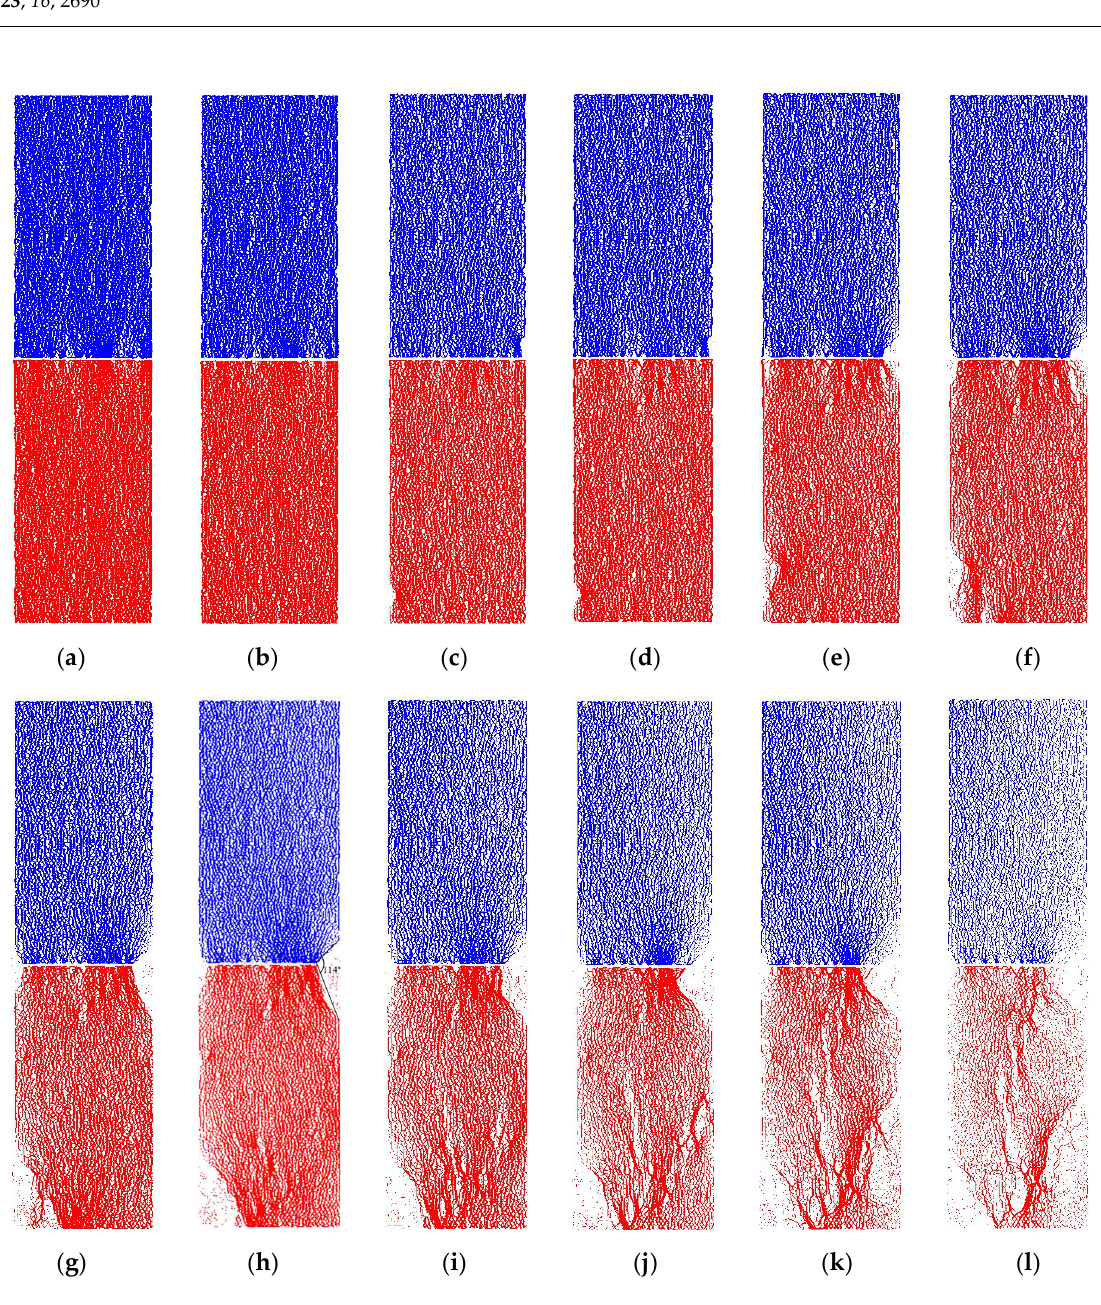
Figure 13. Evolution curve of crack number of serial coal pillar specimens. When the loading timestep was smaller than 14,400, it could be seen that no micro- cracks were generated inside the serial coal pillar specimens. Micro-cracks firstly ap- peared in both the upper coal specimen and bo(cid:308)om coal specimen when the timestep ranged from 14,400 to 15,000, which were mostly distributed near the interface, as shown